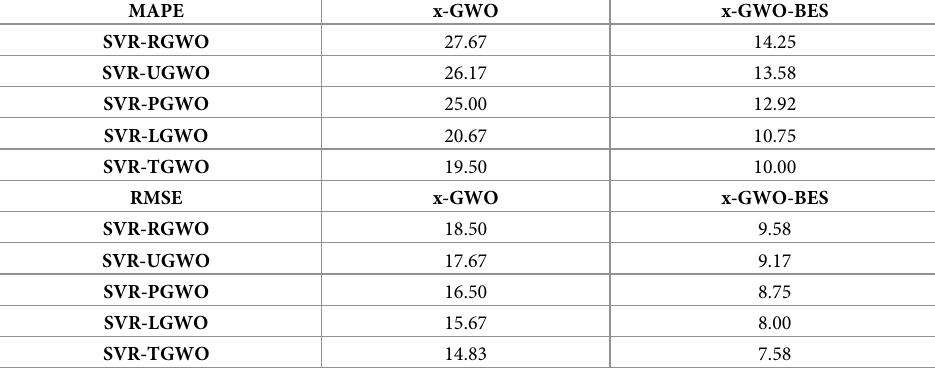
Table 2. Error measure for traffic prediction for proposed SVR–x–GWO-BES and SVR–x–GWO—MAPE and RMSE. MAPE